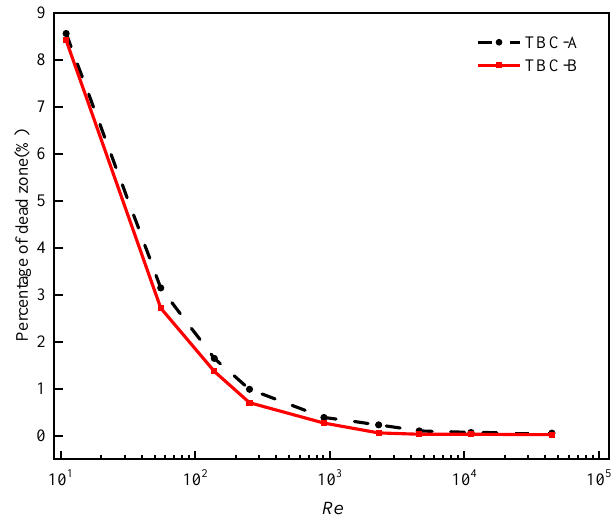
Figure 19. Dead zone percentage.